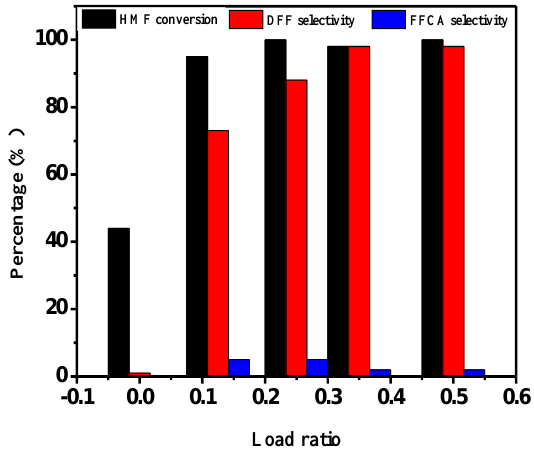
Figure 3. Effects of the VPO loading amount on the oxidation of HMF to DFF. HMF (25.2 mg, 0.2 mmol), VPO/P-C (10 mg), and DMSO (2 mL) for 10 h in air. HMF — 5-hydroxymethylfurfural; DFF — 2,5-diformylfuran.